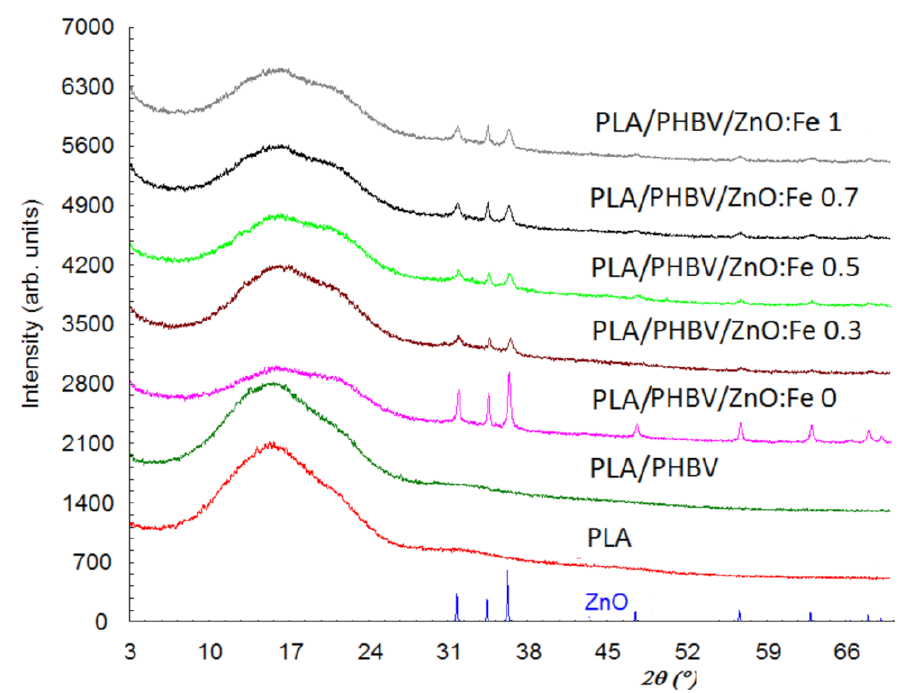
Figure 6. X-ray diffraction patterns of PLA/PHBV/ZnO:Fex samples compared with ZnO NPs, PLA film, and PHBV